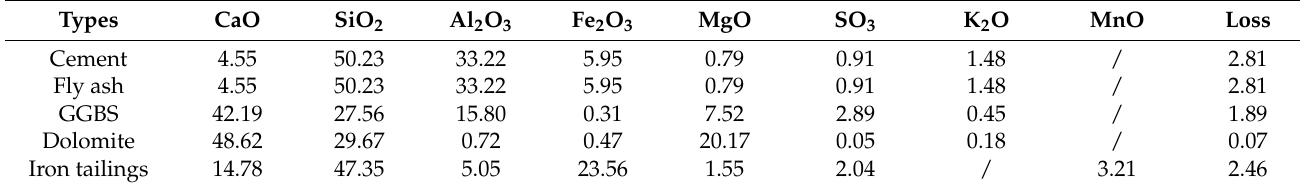
Table 2. Chemical composition of the cementitious materials/%.